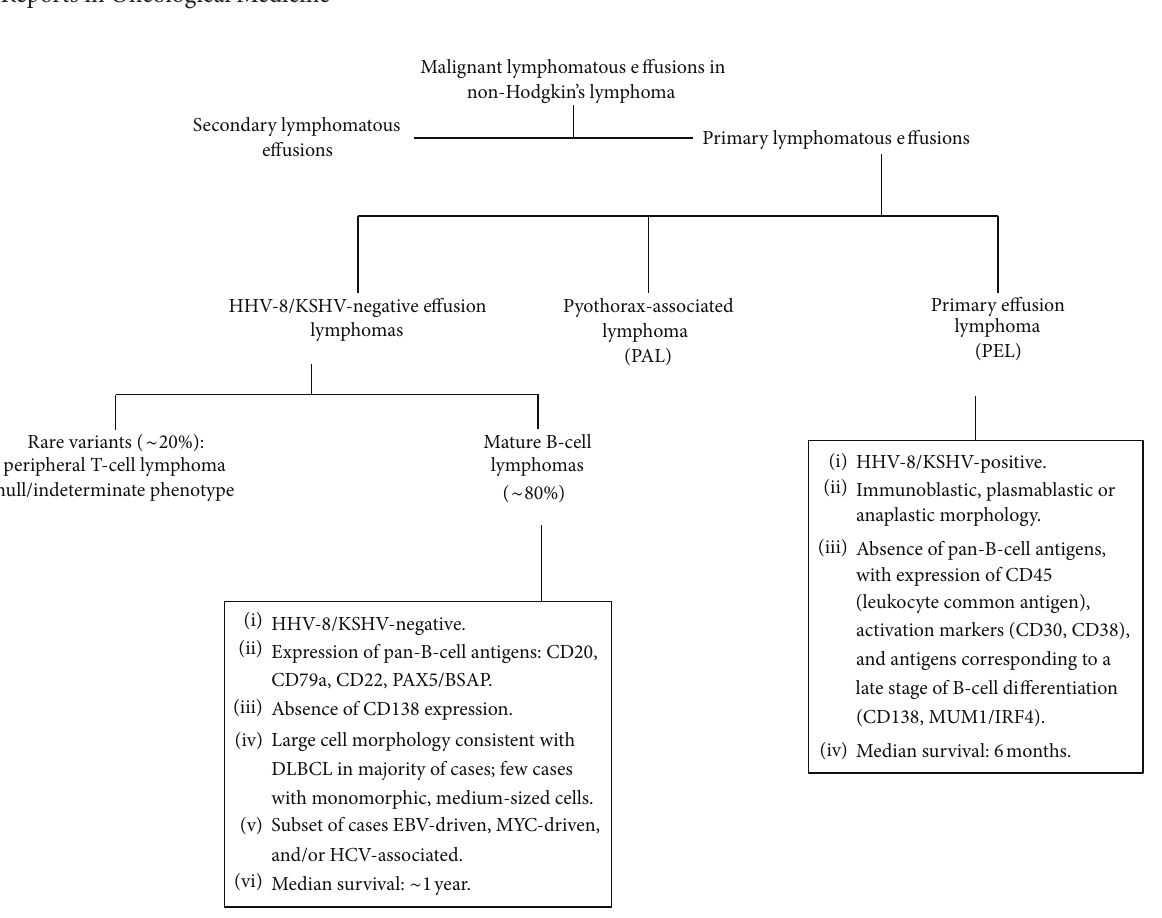
F 3: A schema of malignant lymphomatous effusions in non-Hodgkin’s lymphoma highlighting the differences between HHV8- associated PEL and HHV8-negative